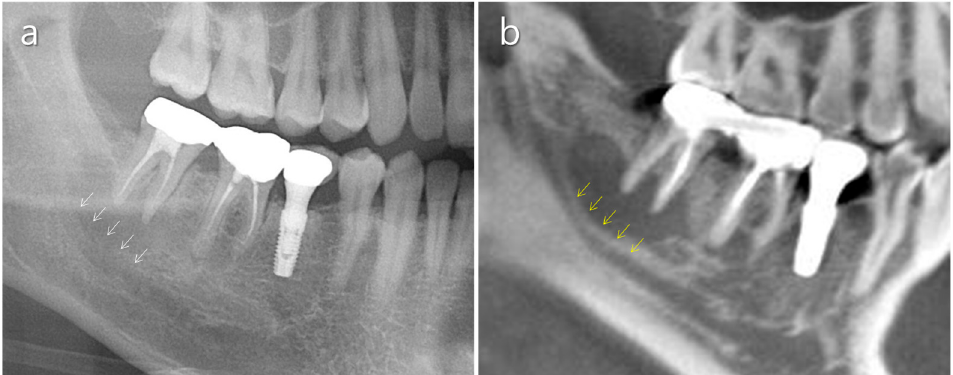
Figure 5. Usefulness of CBCT for identifying the mandibular canal. ( a ) Unclear mandibular canal border in a conventional panoramic radiograph. Periapical bone resorption adjacent to the mandibular canal makes identification of the upper border of the canal difficult (white arrows). ( b ) A CBCT scan shows the upper border of the mandibular canal remarkably well (yellow arrows).